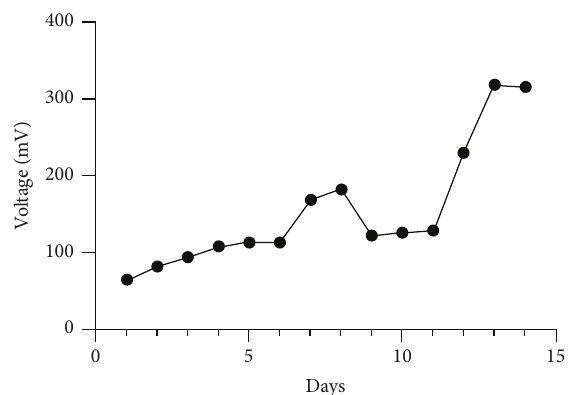
Figure 7: Voltage output from a double-stacked in series MFC unit containing an electrode size of 10cm 2 with H. salinarum at pH 6.4 over 14 days of incubation at 37 ° C at 50rpm oscillation. Each data point is the daily average voltage (mV) recorded every 30 minutes over 14